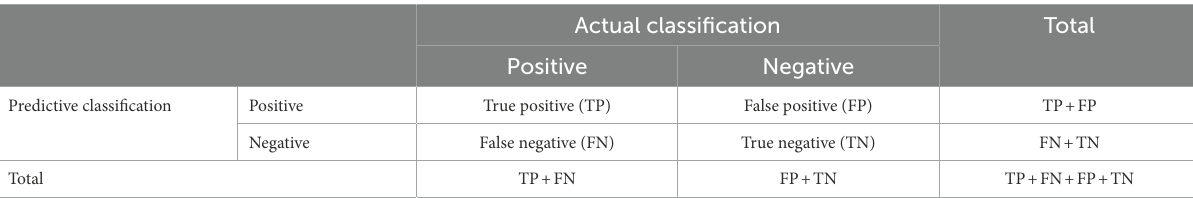
TABLE 1 Confusion